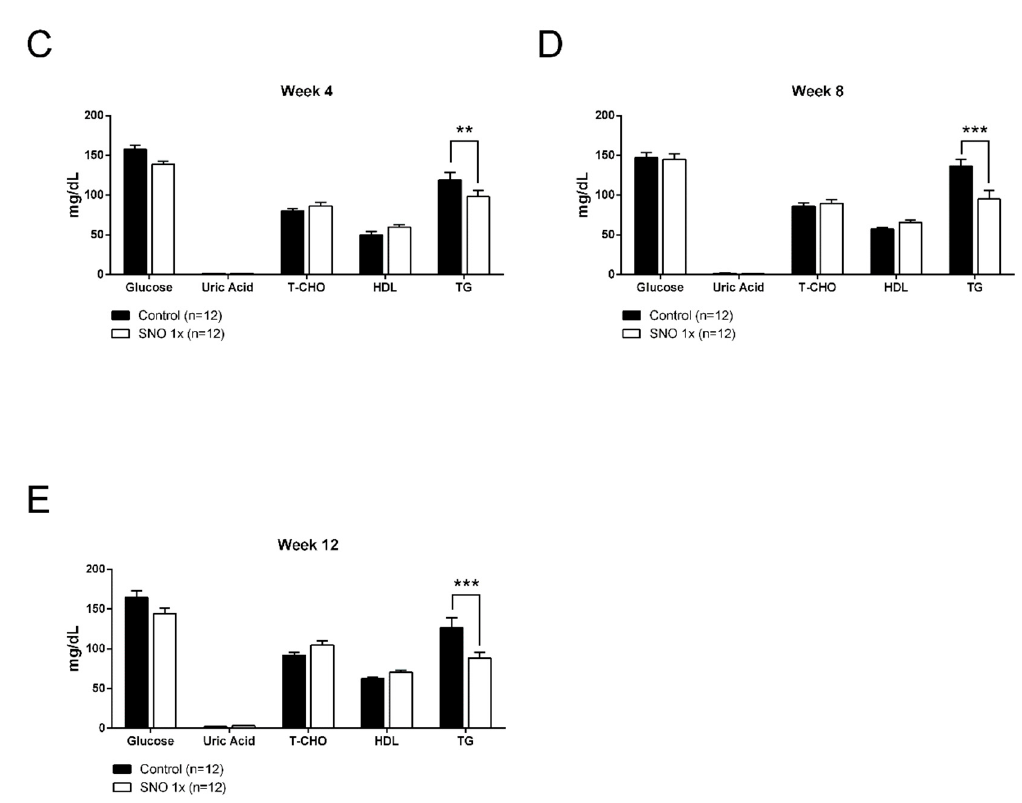
Figure 6. Body weight changes OA-control vs. OA-HA ( A ), or OA-control vs. OA-SNO and SNOHA ( B ). Metabolic profile of OA-control vs. OA-SNO rats (glucose, uric acid, total cholesterol, high-density lipoprotein (HDL), and triglyceride (TG)) at the 4th week ( C ), 8th week ( D ), and 12th week ( E ) after ACLT + MMx surgery. Values are expressed as the mean ± SEM, and two-way ANOVA and Tukey / Sidaks’s multiple comparisons test were used to analyze the data. # / * p < 0.05, ## / ** p < 0.01, ## / *** p < 0.001.